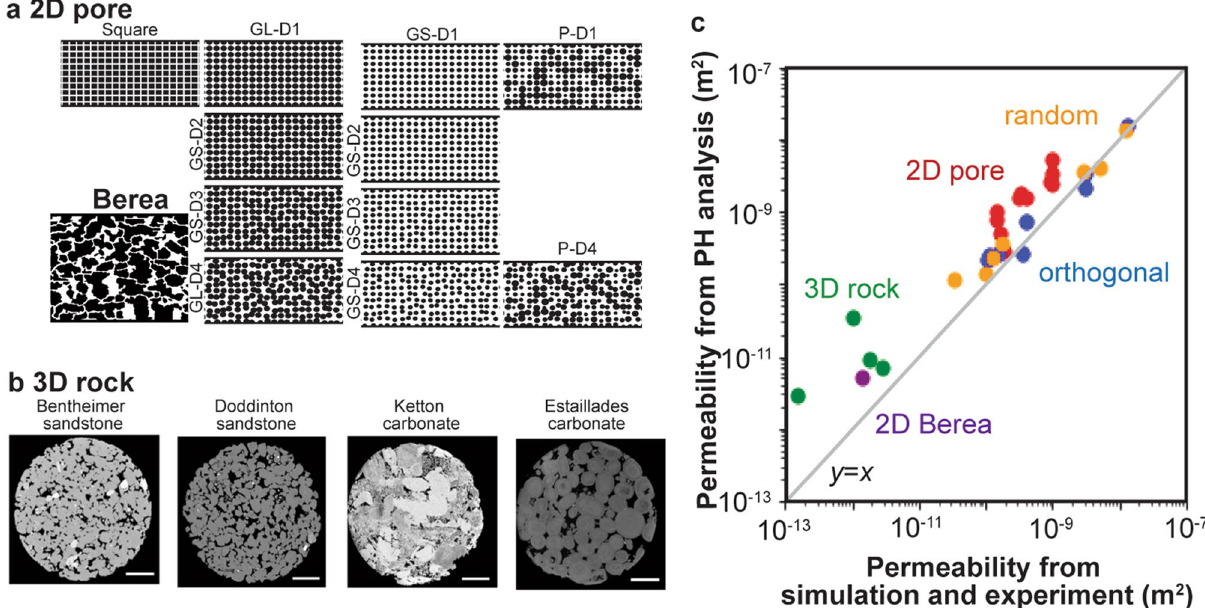
Figure 8. Estimation of permeability by persistent homology (PH) analysis. ( a ) 2D images from Mehmani and Hamdi 39 , ( b ) 3D rock images from Andrew et al. 40 , and ( c ) comparison with direct simulation and experiment. The values are listed in Table